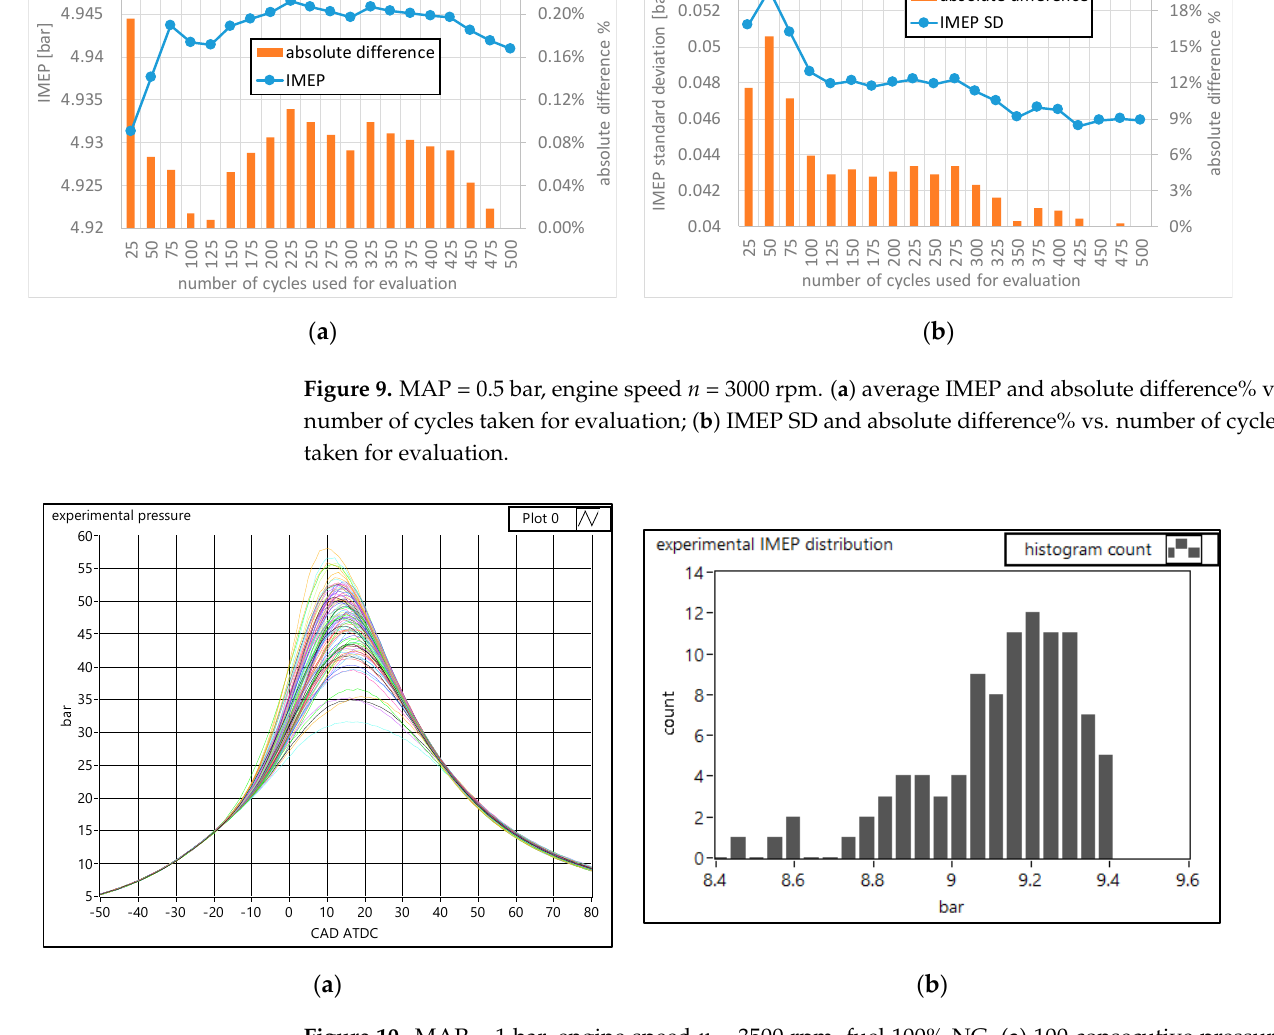
Figure 9. MAP = 0.5 bar, engine speed n = 3000 rpm. ( a ) average IMEP and absolute difference% vs. number of cycles taken for evaluation; ( b ) IMEP SD and absolute difference% vs. number of cycles taken for evaluation.